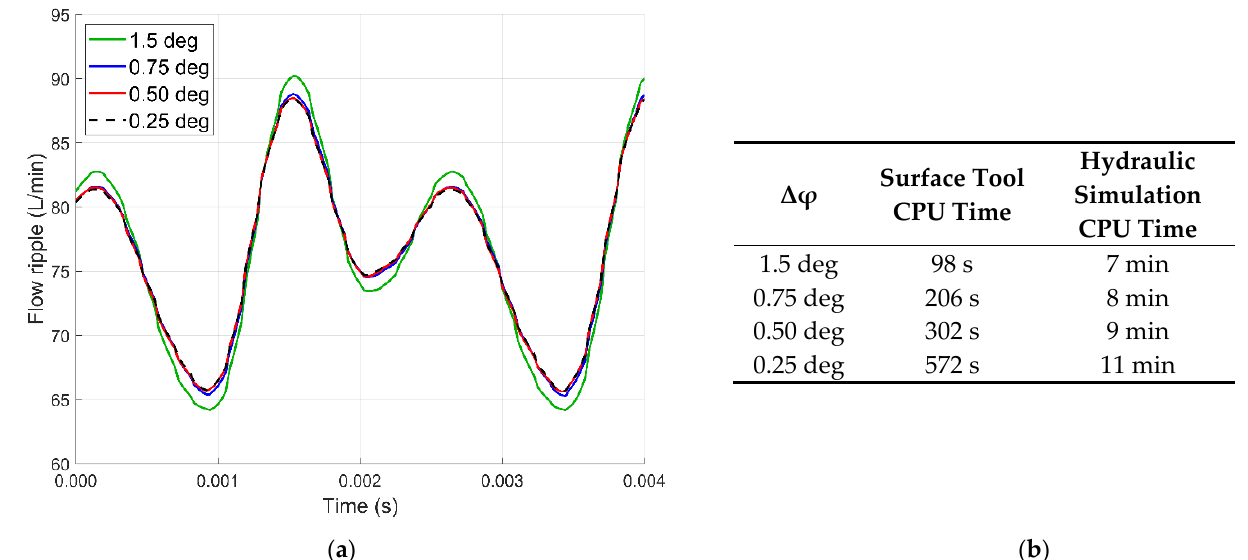
Figure 6. Variation of “saving delta angle” ( Δφ ): ( a ) Effects of the “saving delta angle” ( Δφ ) variation on the numerical flow ripple; ( b ) Effects of the “saving delta angle” ( Δφ ) on the computational time of the Surface Tool and the Hydraulic Simulation.